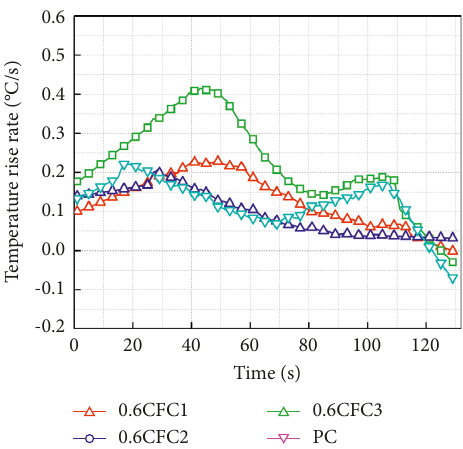
Figure 14: Comparison of temperature rise curves at different doping levels.